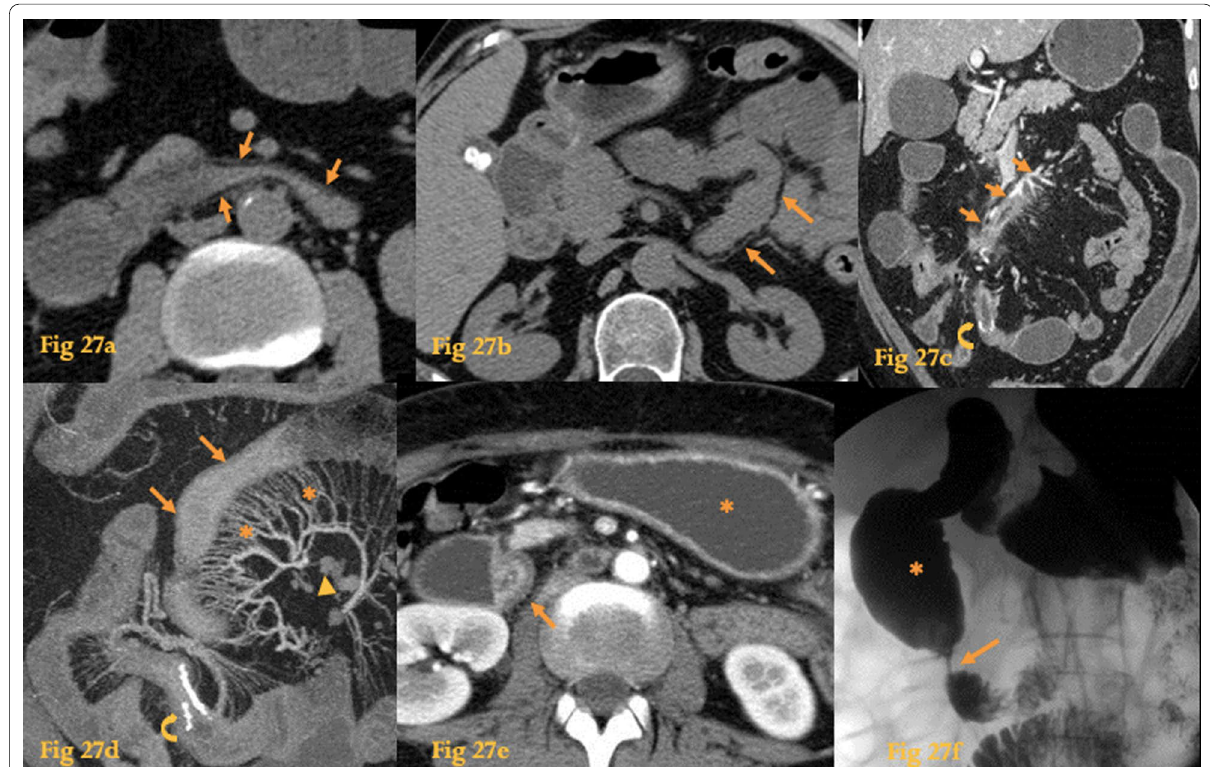
Fig. 27 Chron’s Disease. Plain abdominal CT shows the fat halo sign (arrows) in the wall of the D3 ( a ) and D4 ( b ), in a patient with quiescent Crohn’s disease. CT enterography ( c ) of a CD patient with active disease who previously had a segmental enterectomy—note the surgical clips at the ileal‑ileal anastomosis (curved arrows). There is a fistula between the thickened ileal segment near the anastomosis and the duodenum. MIP coronal reformation ( d ) shows mesenteric engorgement (asterisks) and adenopathy (arrowhead) near a thickened bowel wall segment (arrows). Abdominal CT of another patient with active disease ( e ) shows gastric outlet obstruction (asterisk) and a stricture in D2 that shows the target sign (arrow). Barium study of the same patient ( f ) shows the short stricture (arrow) and dilatation of the proximal duodenum